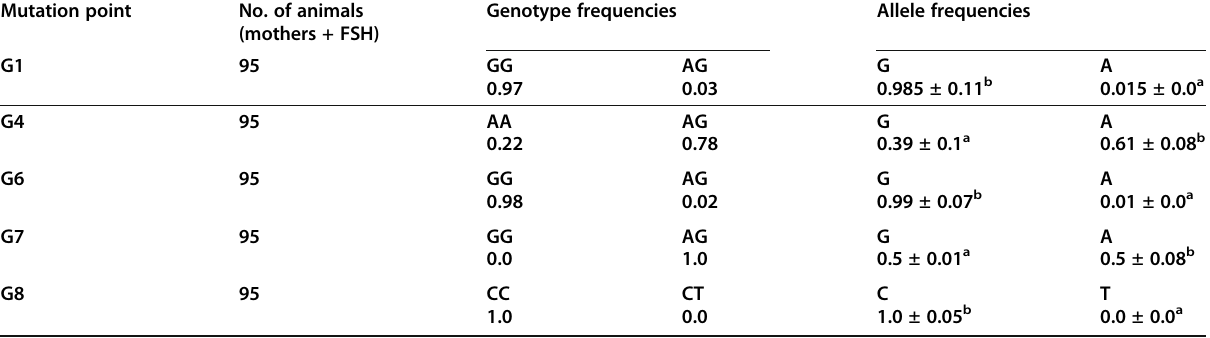
Table 3 Genotype and allele frequencies in mutation points of GDF9 gene of Egyptian sheep Mutation